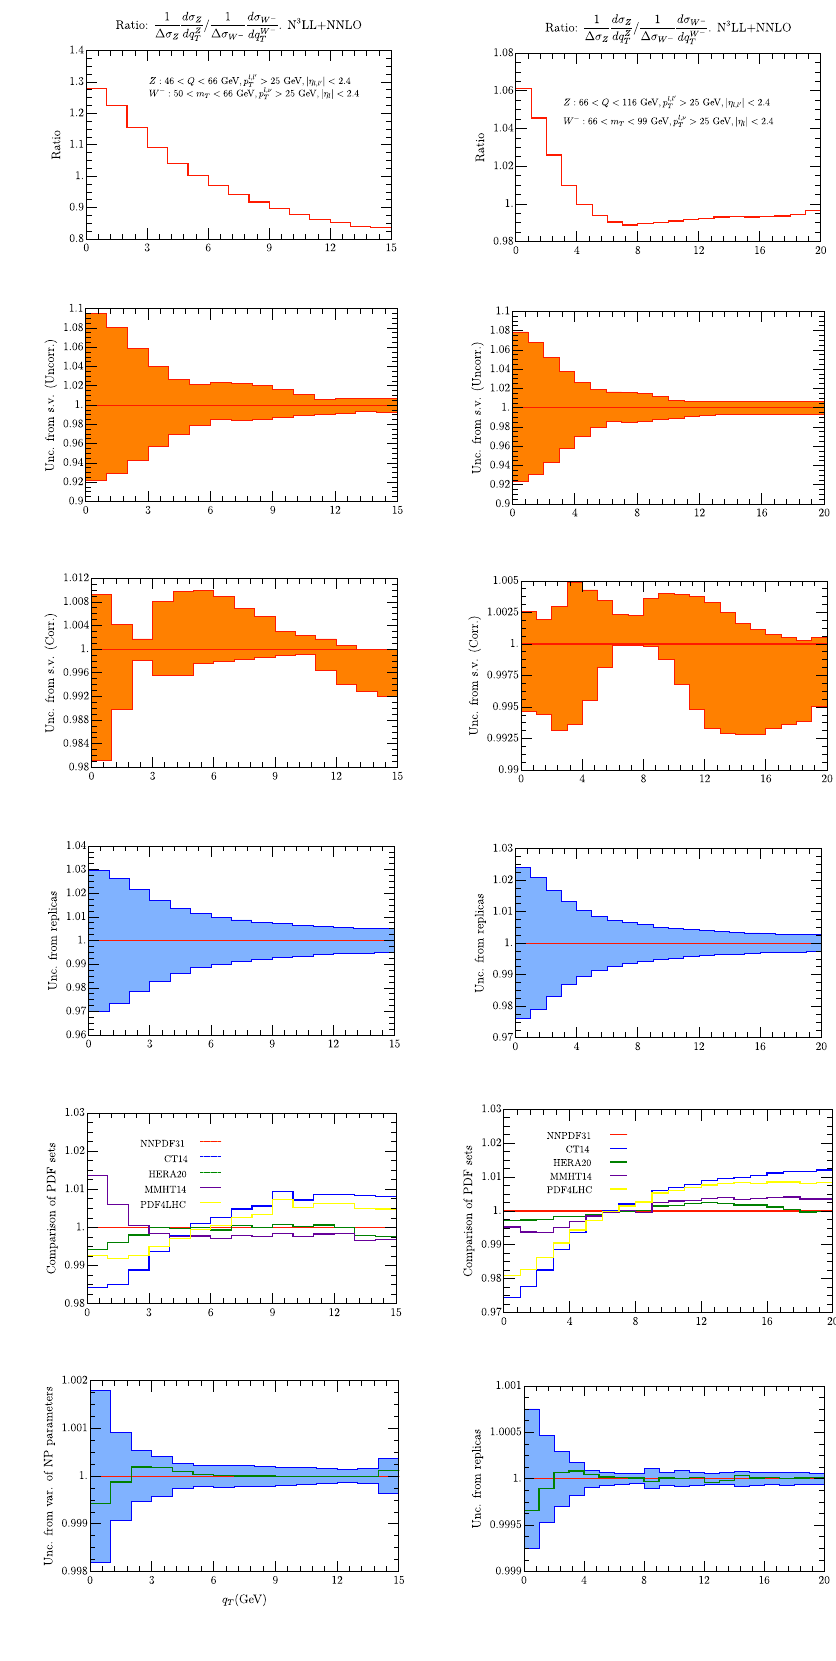
Fig. 4 Ratio of Z / W − spectrum for m T ∈ [ 50 , 66 ] GeV (left column) , and m T ∈ [ 66 , 99 ] GeV (right column). On the first row we have the Z / W − spectrum using the central replica of NNPDF31_nnlo_as_0118 [28]. Uncorrelated and correlated theoretical uncertainties are given in second and third row respectively. In the third line we have the error calculated as a variance in each bin of 100 replicas of the set NNPDF31_nnlo_as_0118 [28]. The uncertainty is referred to the average value of each bin (red line). The value of the observable given by the central replica is represented by the green line. On the fourth line we represent the value of each been with different sets of PDF. On the fifth row we have the uncertainty due to non-perturbative